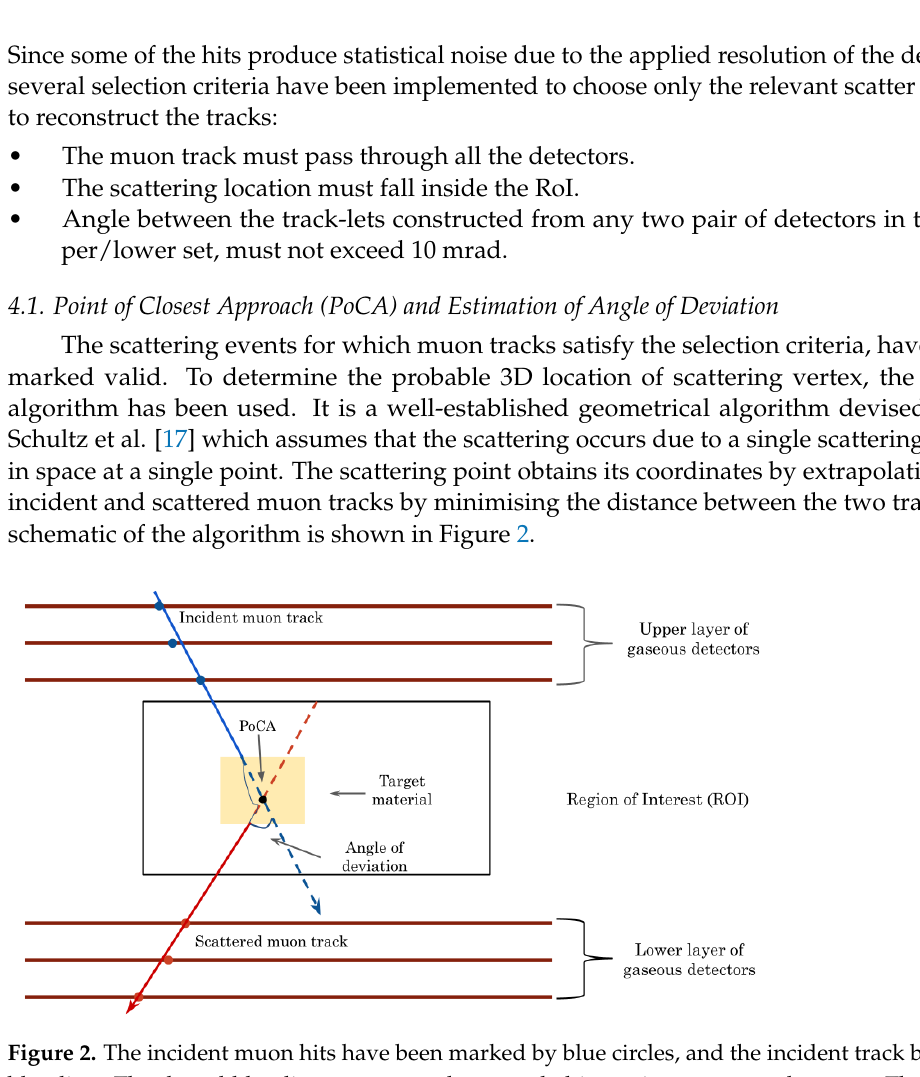
Figure 2. The incident muon hits have been marked by blue circles, and the incident track by solid blue line. The dotted blue line represents the extended incoming muon track vector. The muon hits on the lower set of detectors have been marked using red circles and the outgoing track using a solid red line. The extended outgoing track vector is marked using dotted red line. The PoCA reconstructed point has been marked using a black